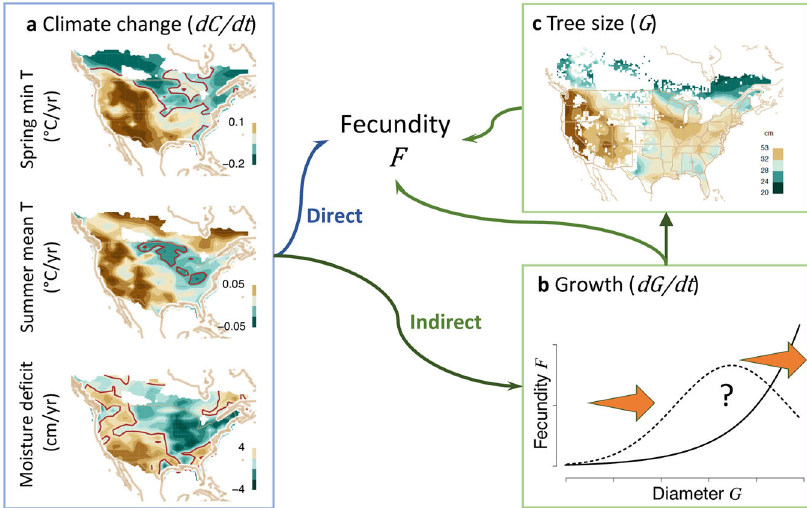
Fig. 2 Trend attribution (TA) includes direct and indirect pathways for terms in Eq. (1). a Trends in climate variables (since 1990) include minimum T in spring, mean summer T , and moisture de fi cit ( D = cumulative monthly PET-P). The brown contour separates positive and negative trends. Shaded contours are green (decreasing) to brown (increasing). b Indirect effects have two elements. An arrow from b to F includes a growth effect (d G /d t ) and a climate- growth interaction ( C × d G /d t ). An arrow from b to c depends on the uncertain relationship between tree diameter G and fecundity F shown in panel ( b ). If fecundity continues to increase with tree size (solid line in b ), then accelerated growth (orange arrows are d G /d t ) moves trees into more productive size classes, but not if fecundity eventually declines (dashed line). c Average diameter of trees (restricted to trees >20 cm) is high in the West, meaning that the effects of tree growth depend on [if] fecundity continues to increase or declines with size in panel ( b ). The effect of size on fecundity (arrow from c to F ) comes through an interaction with climate ( G × d C /d t in Eq.